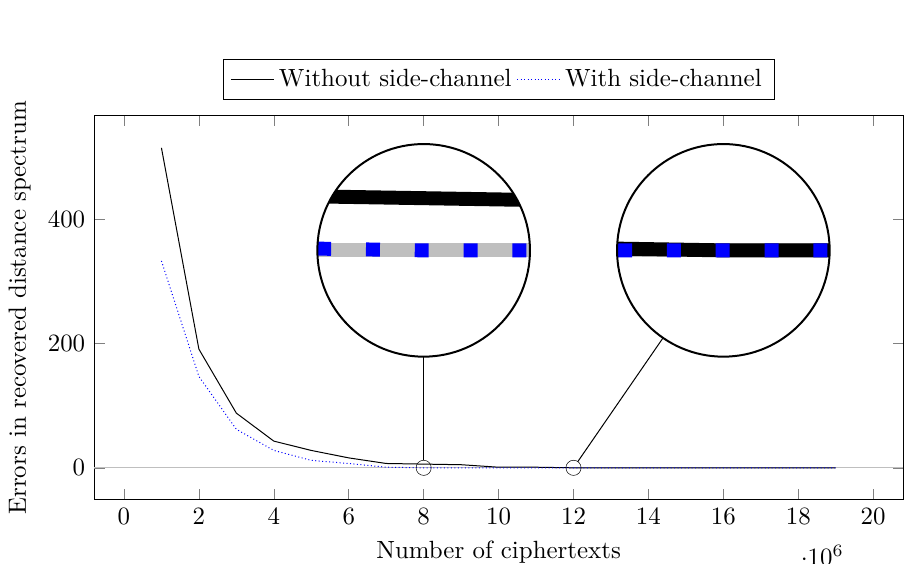
Figure 4: Number of errors in recovered distance spectrum for decoder B . The number of errors is calculated according to the description given in Section 4.4. The results plotted are both with and without side-channel information. The circled values are the lowest number of ciphertexts needed where the number of errors reach zero (and stays there), with and without side-channel information respectively. For easier viewing y = 0 is shown as a grid line.